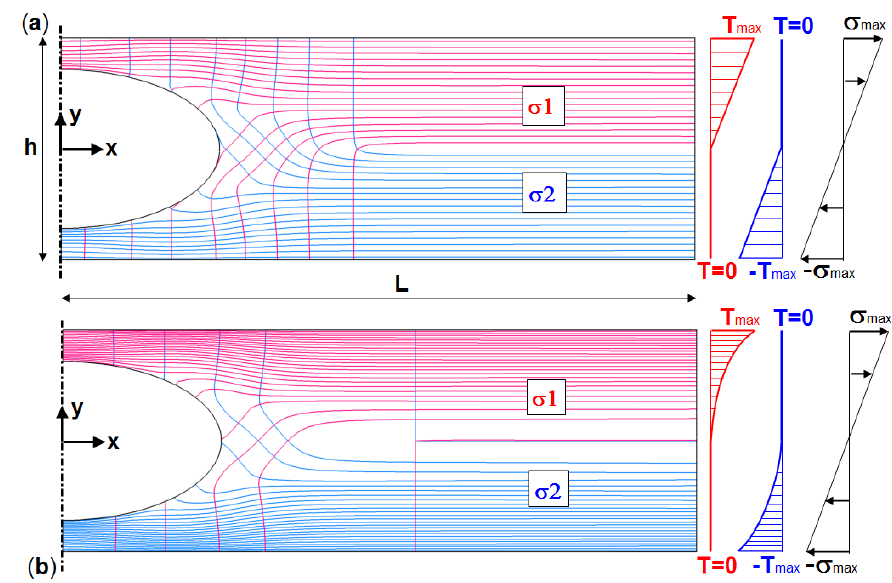
Figure 5. FRP disc with hole under bending: ( a ) Linearly increasing temperature boundary conditions for σ 1 and σ 2 trajectories yield a uniform distribution of fibers (isotherms); ( b ) parabolic temperature boundary conditions yield a weighted distribution of fibers, which carries a bending moment more effectively.